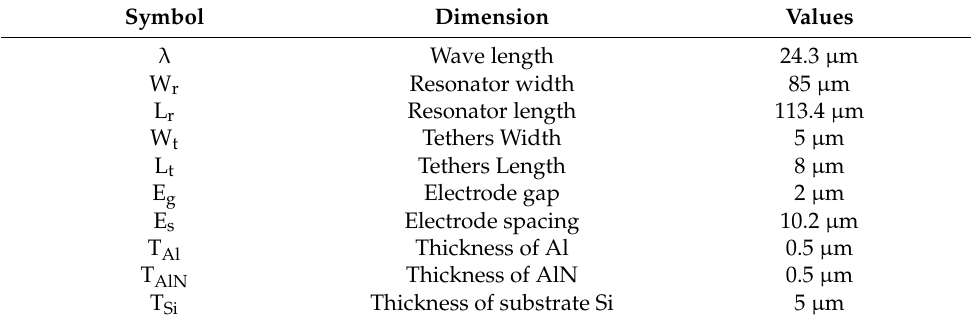
Table 3. The size parameters of the resonator.